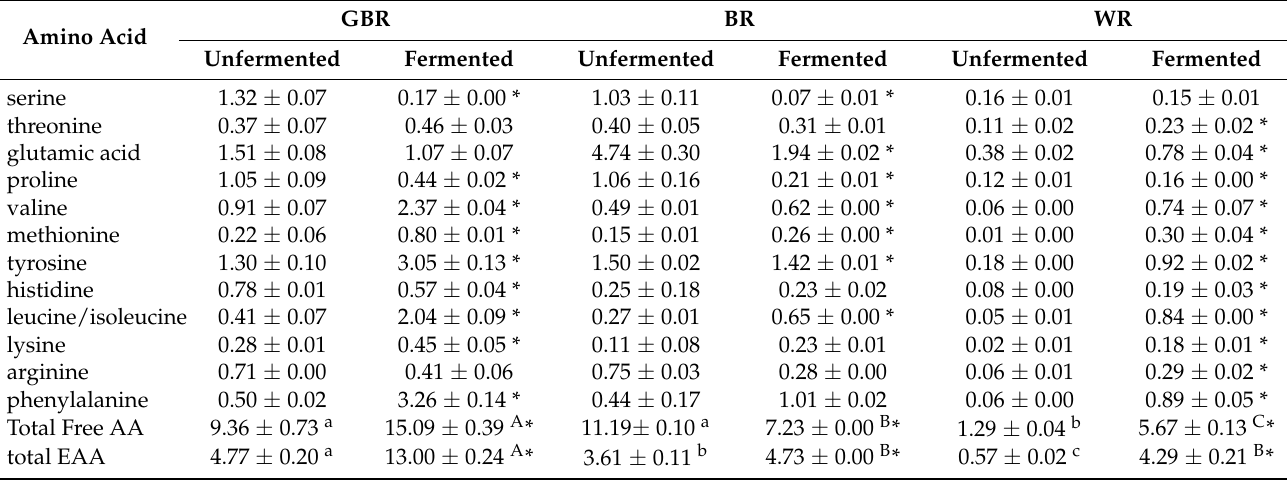
Table 2. Free amino acid contents (mg/100 g dm) in germinated brown rice (GBR), brown rice (BR), and white rice (WR) before and after fermentation.